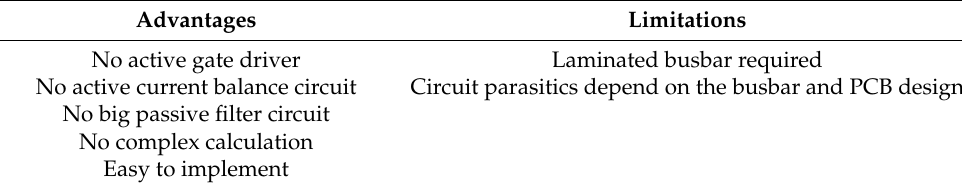
Table 9. Proposed half-bridge circuit advantages and